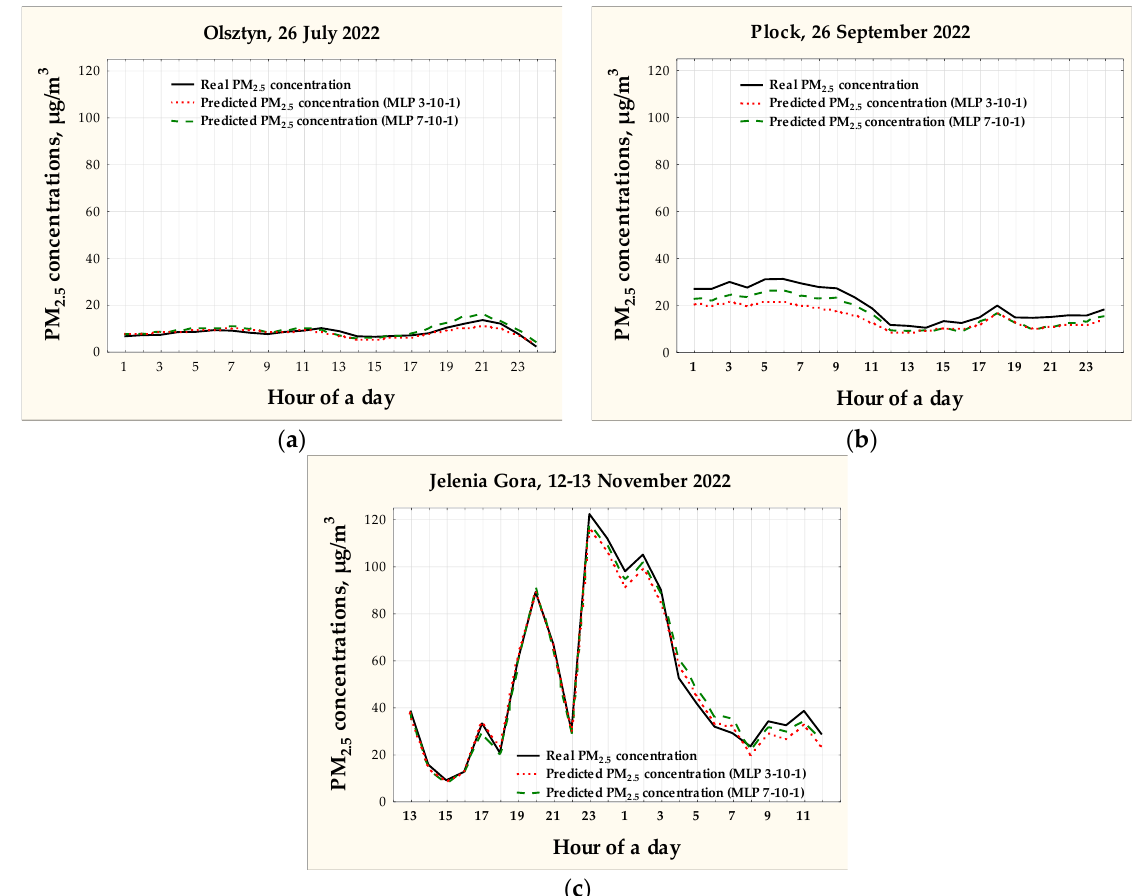
Figure 8. Daily courses of the observed and modeled PM 2.5 concentrations during the selected episodes: ( a ) Olsztyn on 26 July 2022 (MLP 7-10-1: RMSE = 1.41 µg/m 3 ; MLP 3-10-1: RMSE = 1.20 µg/m 3 ); ( b ) Plock 26 September 2022 (MLP 7-10-1: RMSE = 3.73 µg/m 3 ; MLP 3-10-1: RMSE = 6.22 µg/m 3 ); ( c ) Jelenia Gora on 12 – 13 November 2022 (MLP 7-10-1: RMSE = 3.55 µg/m 3 ; MLP 3-10-1: RMSE = 4.01 µg/m 3 ).